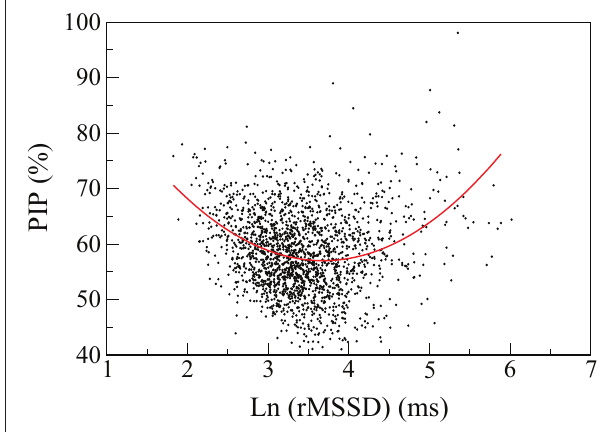
FIGURE 4 | Scatter plot of PIP vs. the natural logarithm of rMSSD. The fitting line is described by the equation: PIP = − 26.2*ln(rMSSD) + 3.54*[ln(rMSSD)] 2 + 105.3. The 95% CI for the 1st, 2nd and 3rd terms are: ( − 30.0 − − 22.5), (3.03–4.05) and (98.5–112.1), respectively. PIP, percentage of inflection points; rMSSD, root mean square of the successive